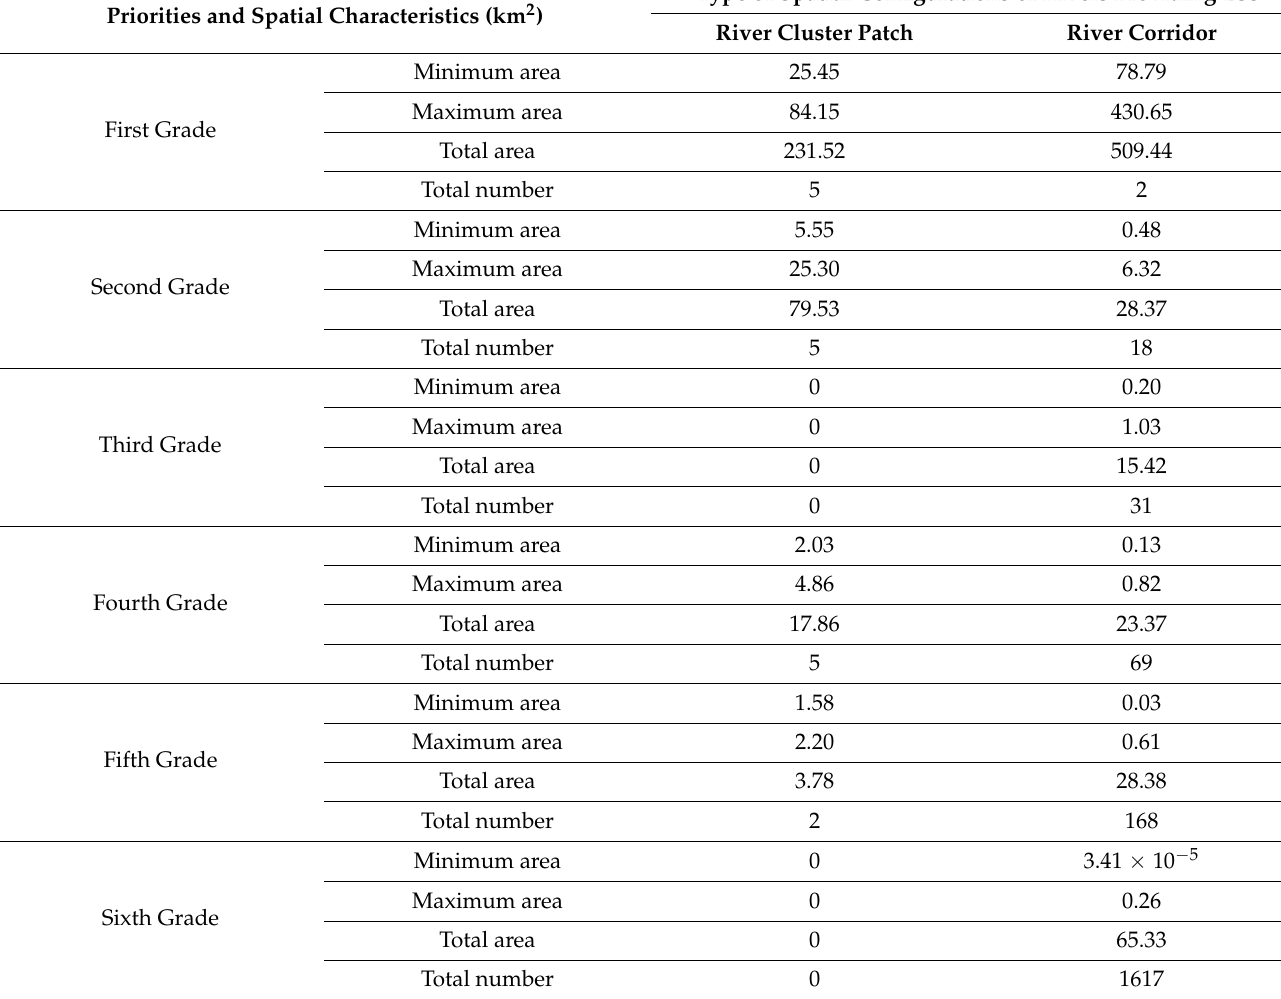
Table A7. Statistical results of six water linear spaces priorities.